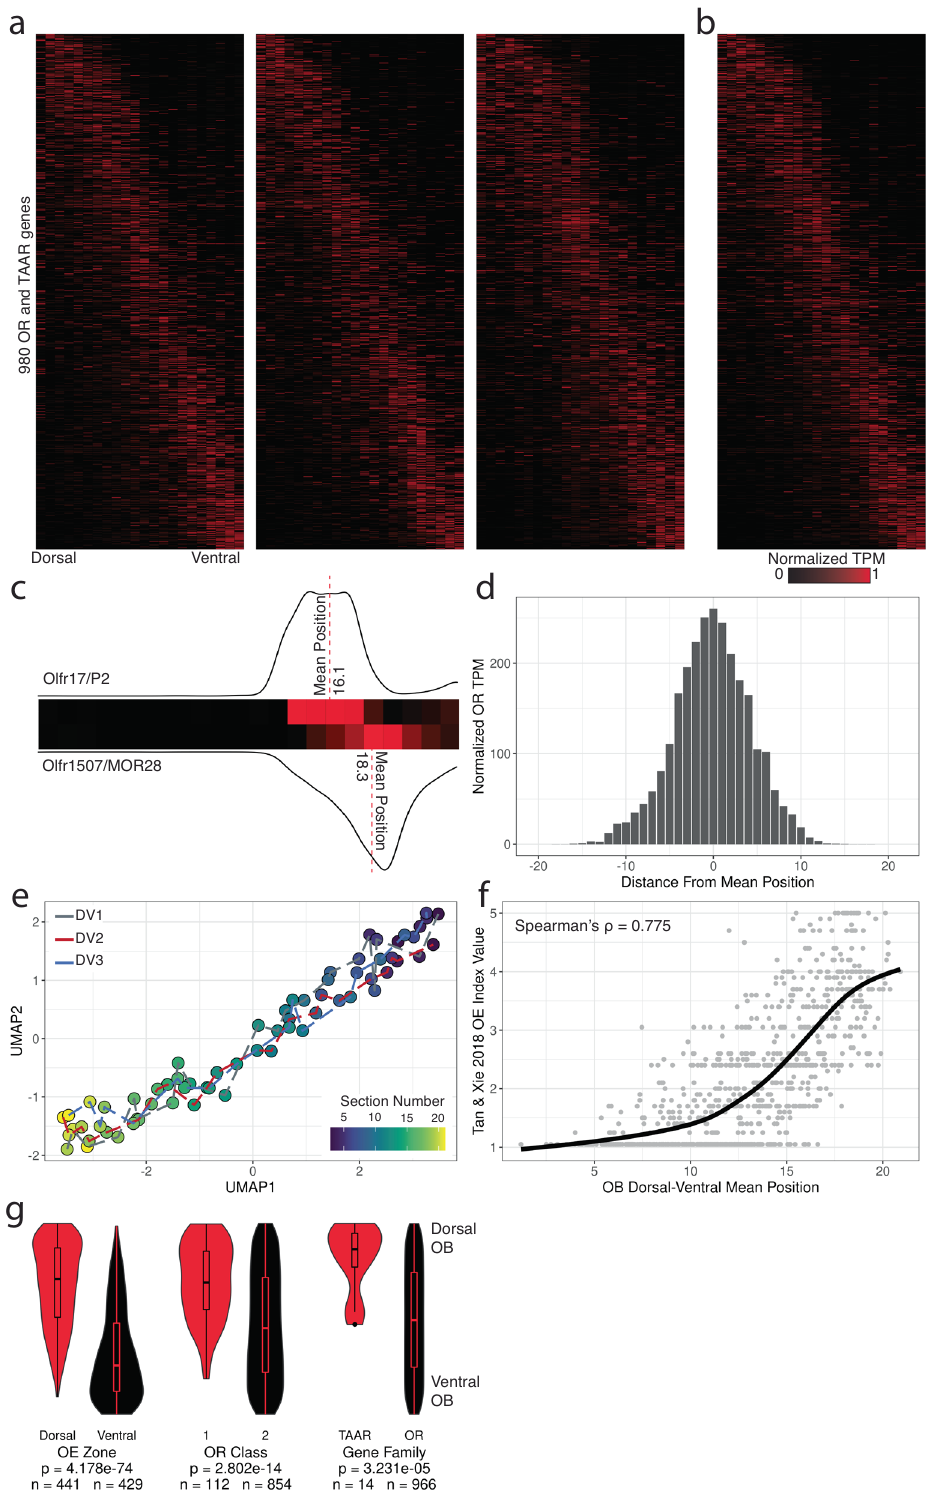
d Distribution of normalized TPM (maximum observed value= 1, minimum observed value = 0) for all 980 OR and TAAR mRNA from position of mean expression. e UMAP projection of 22 DV sections from all three replicates. f Loess- smoothedregressionofOEDVindexfromTanandXie, Chem.Senses 2018acrossDV mean positions from our targeted spatial data. g Distribution of ranked DV mean positionsforthe980ORandTAARtranscriptsbyOEzone,ORclass,andgenefamily. Statistic is Mann-Whitney U-test. Source data provided as a Source Data fi